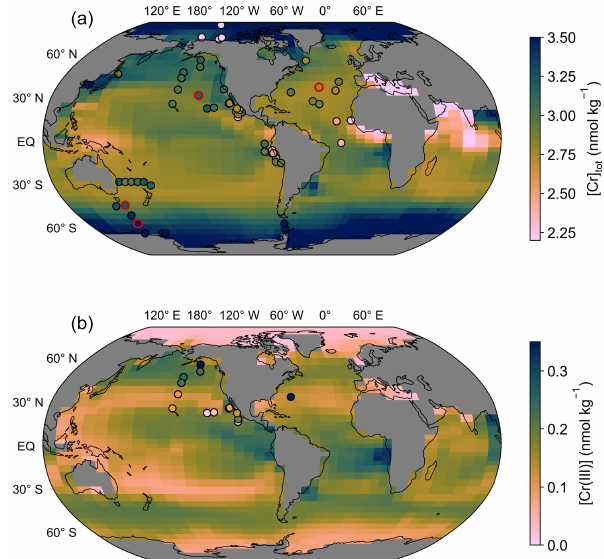
Figure 3. (a) Surface ocean total dissolved Cr concentration sim- ulated in the control run. Filled circles mark surface seawater ob- servations (top 40m, equivalent to the height of the uppermost grid cell) with colors on the same scale as background model data. Cir- cles with red edges are stations depicted in Fig. 6. (b) Same as (a) but for Cr(III)